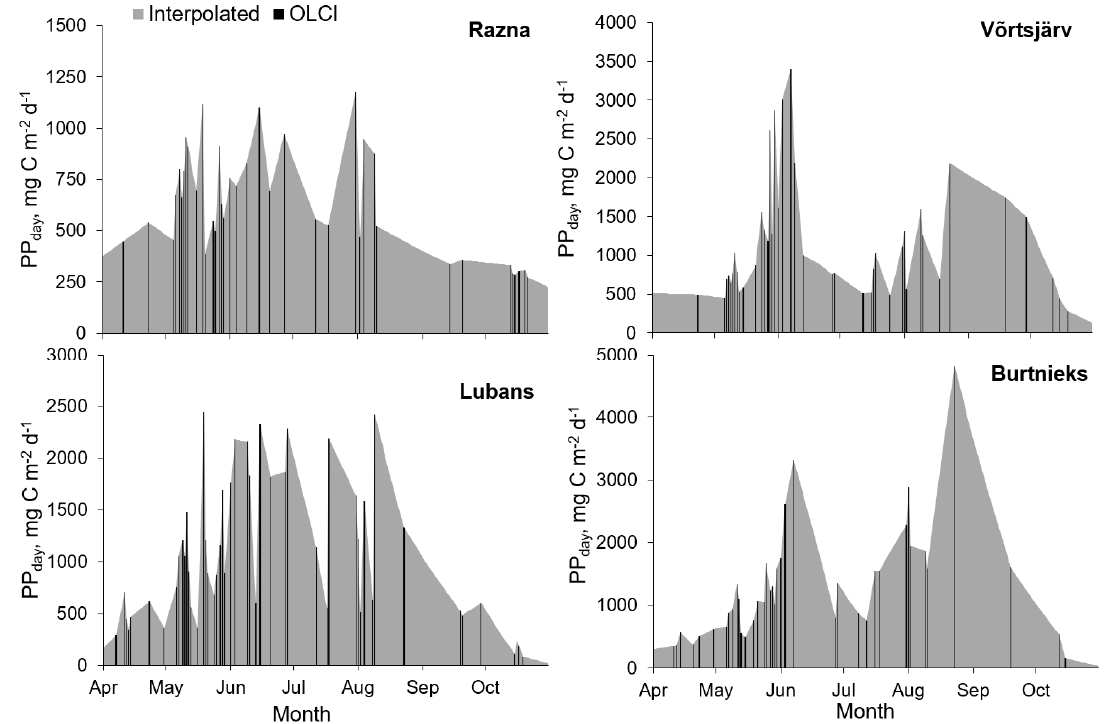
Figure 6. Temporal variability of daily average areal primary production (PP day , mg C m − 2 d − 1 ) in four studied lakes during 01 April 2018–31 October 2018. The modelled values from Ocean and Land Color Instrument (OLCI) data are shown with black columns and interpolated values between them as a gray area.